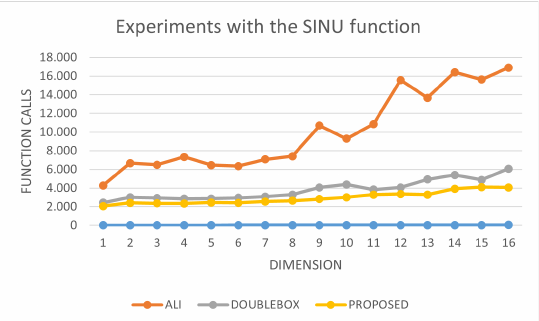
Figure 3. Experiments with the SINU function for a series of problem dimension from n = 2 to n = 32.